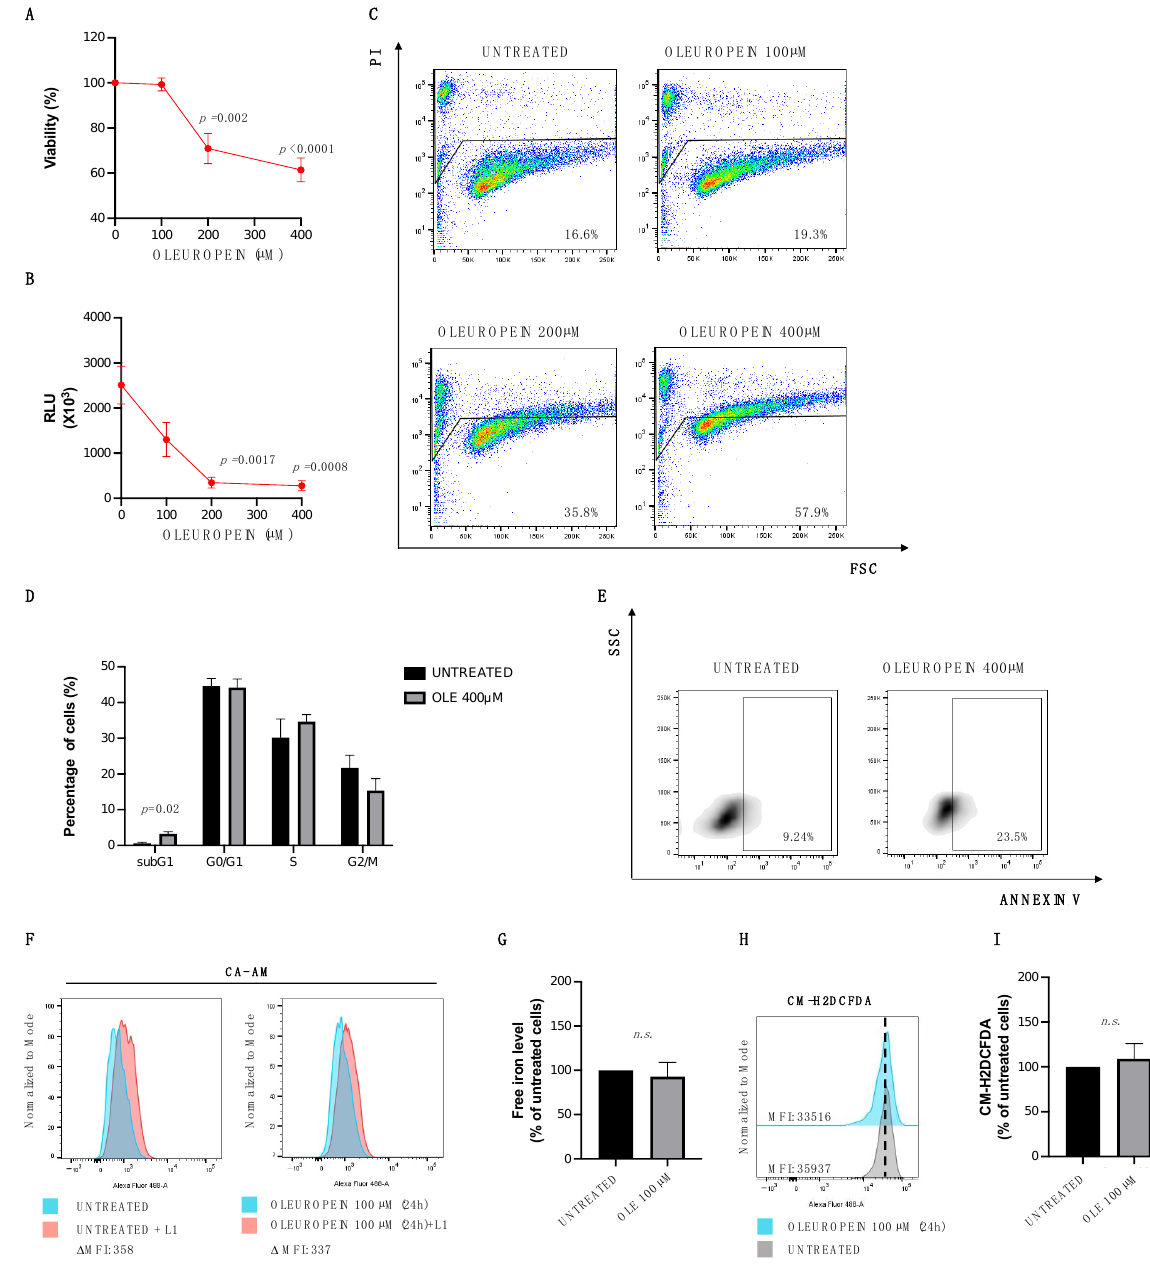
Figure 5. Oleuropein acts as a pro-oxidant in MCF-7 breast cancer cells. MCF7 cell viability and mortality were measured after 24 h of OLE treatment at the concentrations indicated in the figure by Trypan Blue dye exclusion ( A ), Cell Titer-Glo Luminescent cell viability assay ( B ), and by PI staining ( C ). ( D ) A bar diagram of the number of cells in each phase of the cell cycle based on PI staining and ( E ) representative density plot of Annexin V binding assay of in vitro-cultured un- treated and treated MCF-7 cells with OLE (400 μ M) analyzed by flow cytometry. ( F ) Flow cytometry histogram showing LIP levels assessed using Calcein-AM assay in HEY cells untreated and treated with OLE (100 μ M) for 24 h. ( G ) A bar diagram showing LIP levels presented as the % of control (untreated HEY cells). ( H ) Flow cytometry histogram showing the analysis of cytosolic ROS meas- ured upon staining with CM-H2DCFDA in MCF-7 cells untreated and treated with OLE (100 μ M) for 24 h. ( I ) A bar diagram showing ROS levels presented as the % of control (untreated MCF-7 cells). Values (mean ± SEM; n = 3) are shown. Statistically significant difference was determined by Student’s t -test. Not statistically significant: n.s.